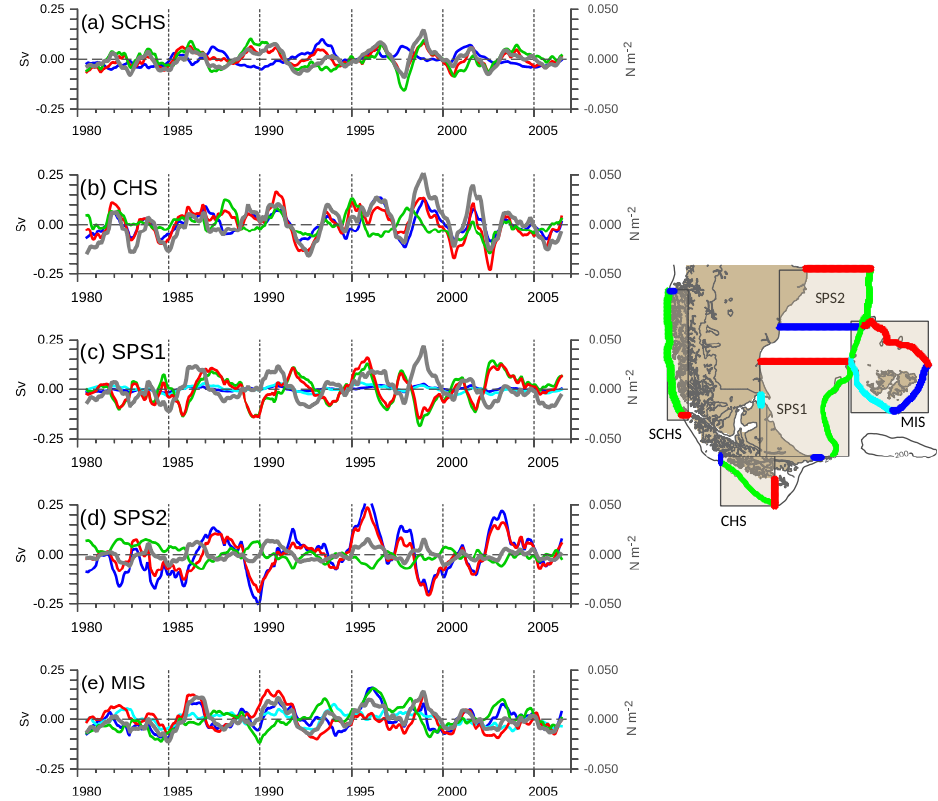
Figure 10. Monthly transport anomalies across the sections of the key areas. From top to bottom: SCHS (a) , CHS (b) , SPS1 (c) , SPS2 (d) , and MIS (e) . On the right is a reference map that shows (in colors) the sections of each key area where the monthly transport has been calculated. The grey line in each panel is the zonal wind stress in the area, calculated in the shaded regions indicated in the reference map. A 12-month running mean is applied to the data to filter the seasonal signal. Table 1. Correlation between interannual transport anomalies from CMM across selected sections: SCHS (south), CHS (east), SPS1 (LMS and shelf), SPS2 (south), and MIS (southwest and west). High correlations (equal to or above 0.7) are shown in